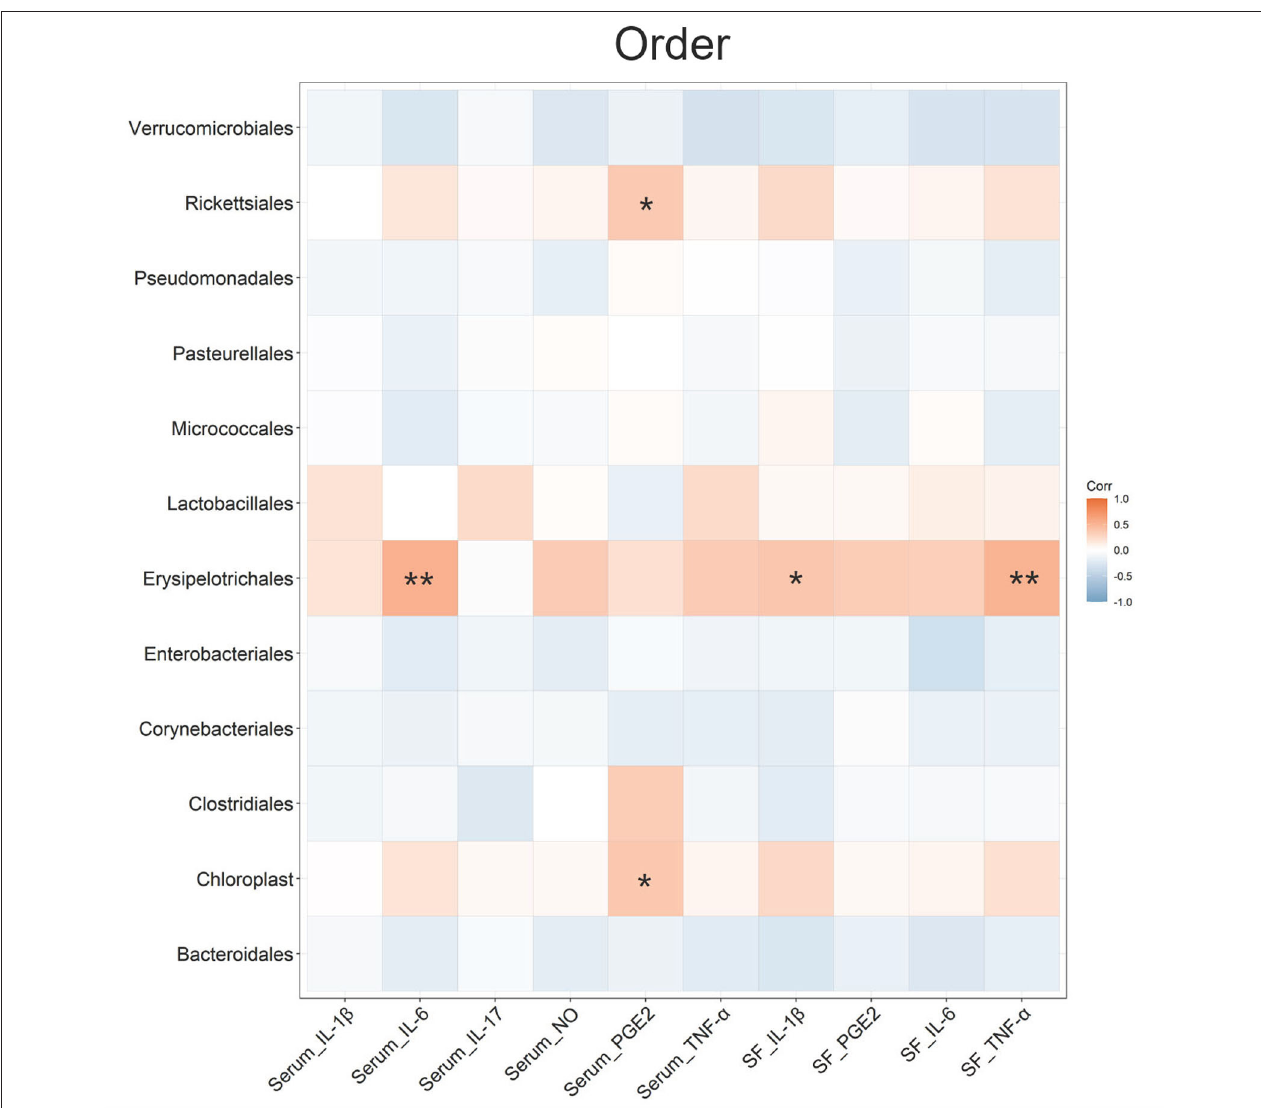
FIGURE 6 | Spearman’s r correlations between the inflammatory cytokines and the gut microbiota in terms of order level. Significant correlations were noted by * P ≤ 0.05, ** P ≤